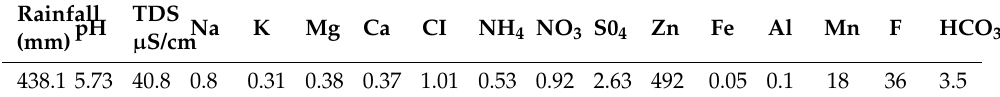
Table 3. Average content of the total dissolved solids in liquid precipitation for Milhostov